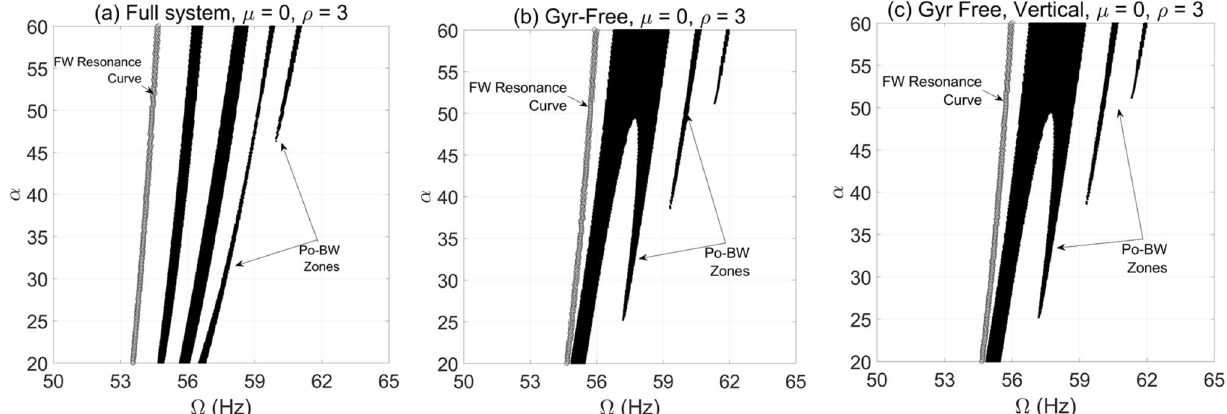
Figure 4. Po-BW zones of rotational speeds at varying angular acceleration rate of overhung intact rotor system with anisotropic bearings including gravity and gyroscopic effects in ( a ); gyroscopic-free system including gravity effect in ( b ); and gravity-free and gyroscopic-free system in ( c